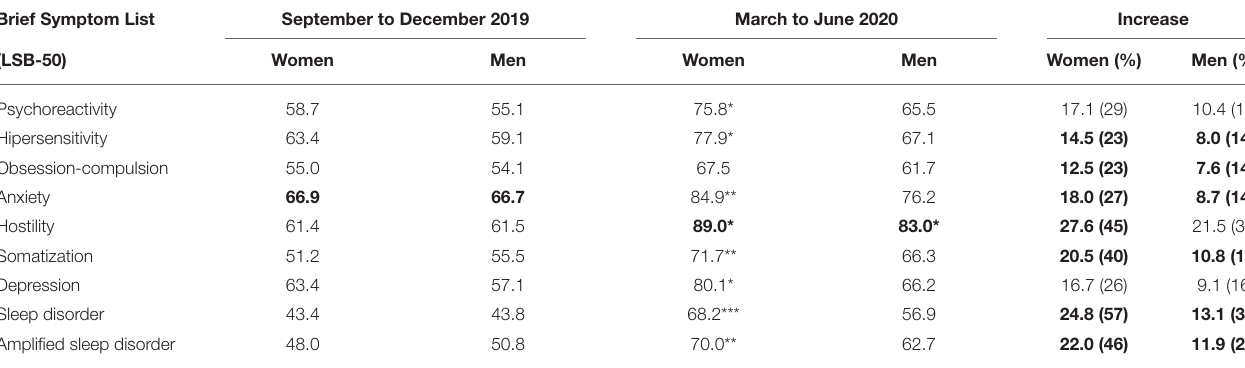
TABLE 3 | Phase II - Psychological and psychosomatic symptoms (PPS) in people with